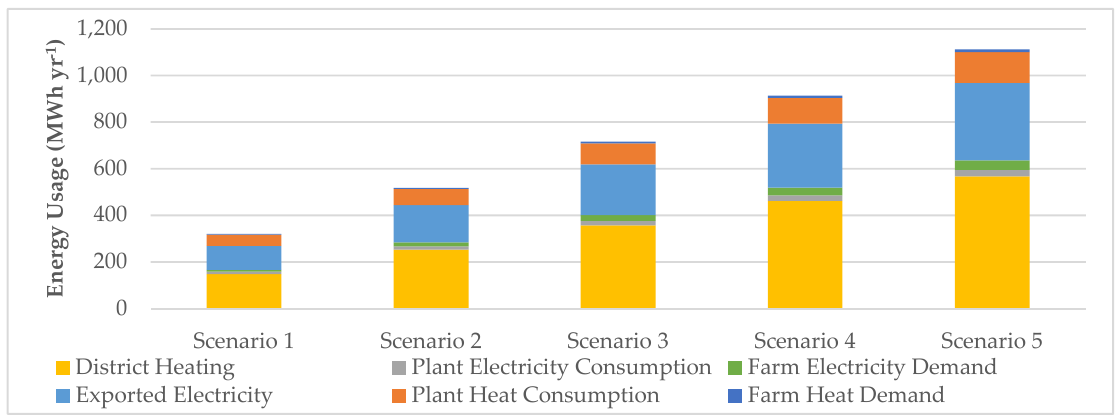
Figure 4. Final electrical and thermal energy usage via the combined heat and power (CHP)